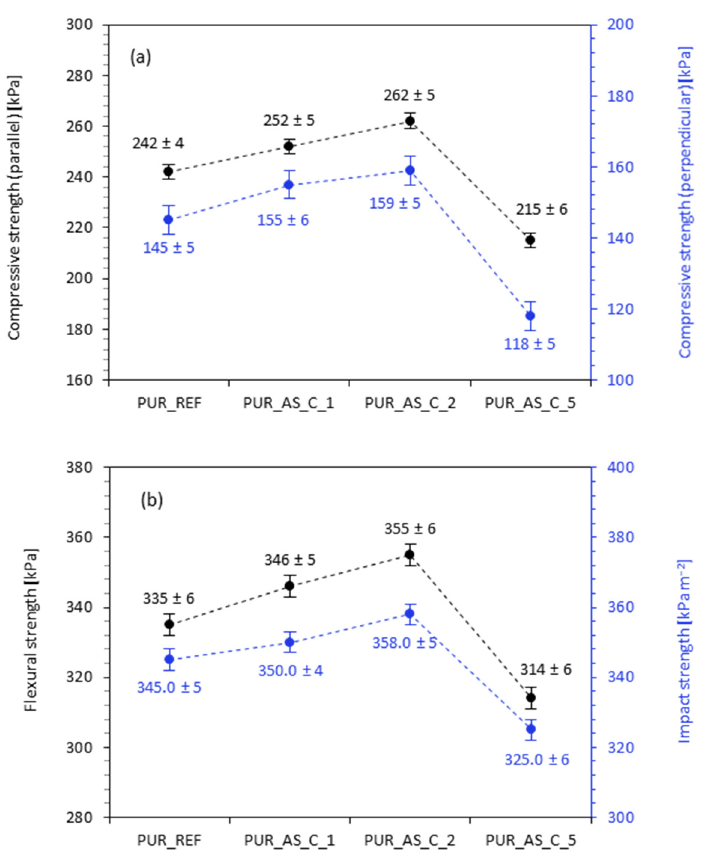
Figure 12. The mechanical performances of PUR composites reinforced with casein/apricot filler—( a ) compressive strength and ( b ) flexural, impact strength.